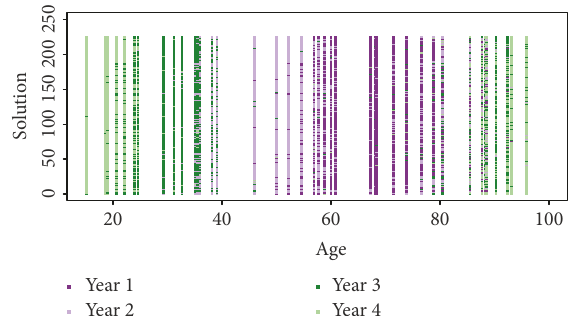
Figure 7: Projection of a Phase I solution (consumption strategyfor thesubsetof40units)ontothefullstockpilebymappingeachunitin the subset to the five adjacent units in the full stockpile with similar